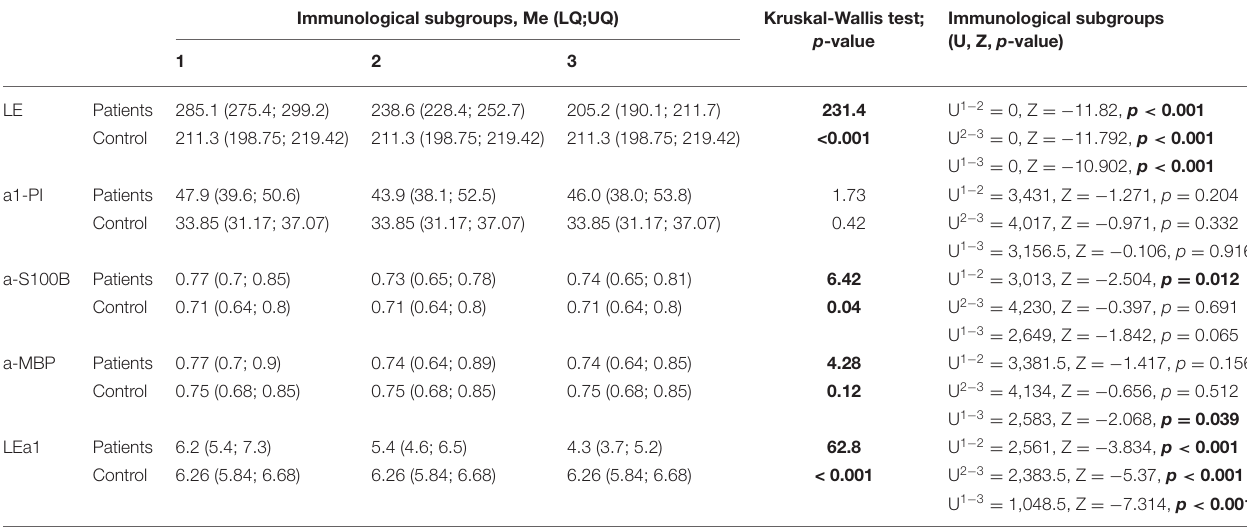
TABLE 4 | Descriptive statistics of neuroinflammatory biomarkers in subgroups of patients and healthy control. Immunological subgroups, Me (LQ;UQ) Kruskal-Wallis test;